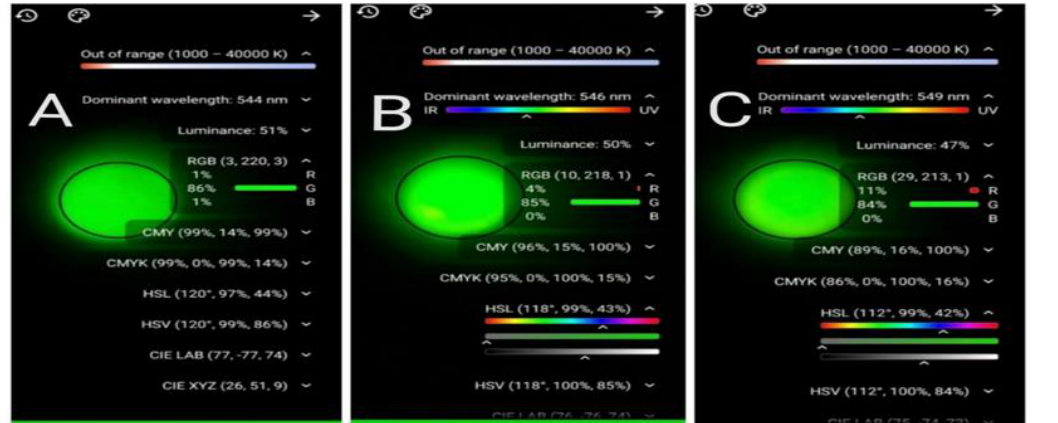
Fig. 5. The images taken to study the concentrations of the detection limit, (a) Image of a concentration of (0.2 mg/L). (b) Image of a concentration of (0.4mg/L). (c) Image of a concentration of